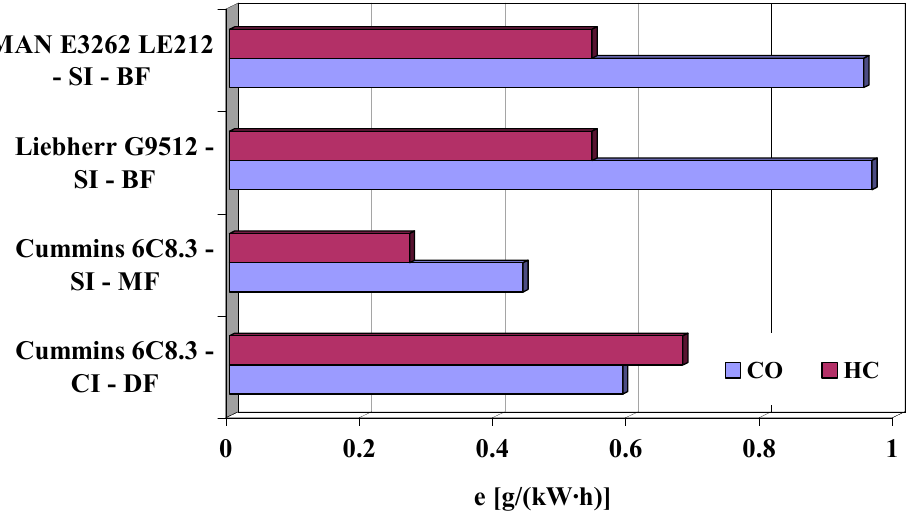
Figure 10. Specific brake emission of carbon oxide and hydrocarbons in the D2 test for the studied engines running on diesel fuel (DF), methane fuel—natural gas (MF) and biogas (BF).